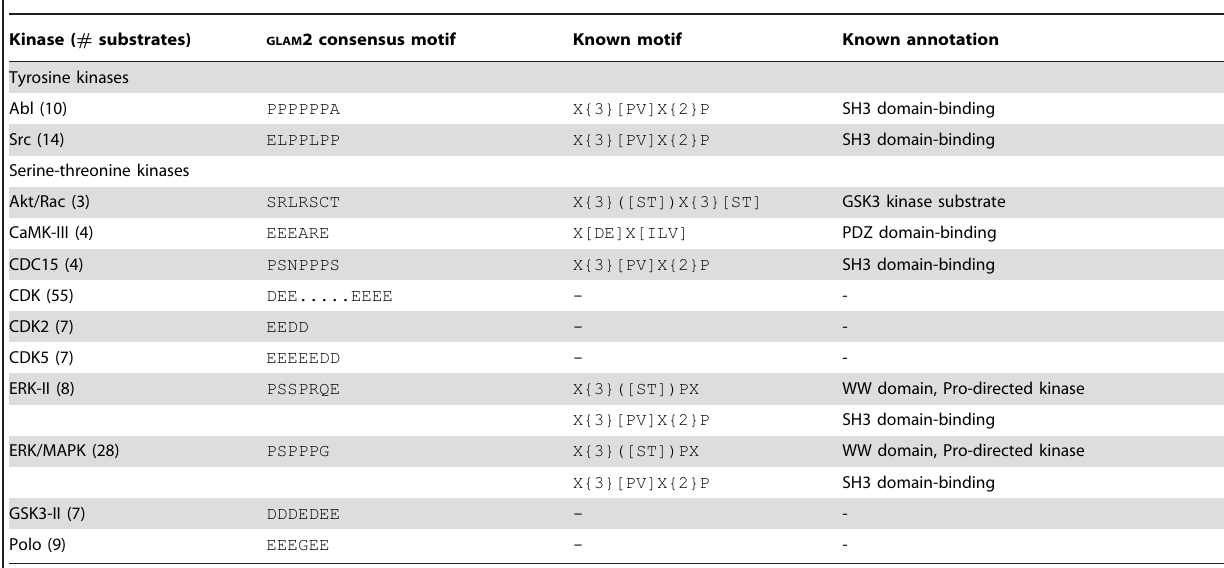
Table 4. GLAM 2 motifs in protein kinase